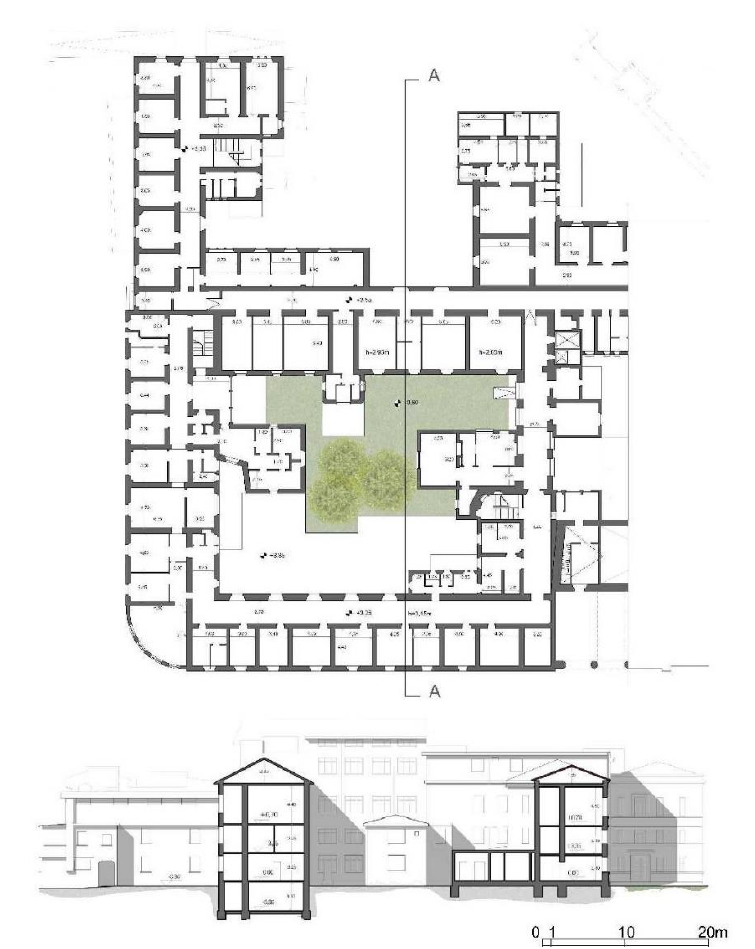
Figure 6. First floor and section of the portion of the building built over the years 1931 – 1939.